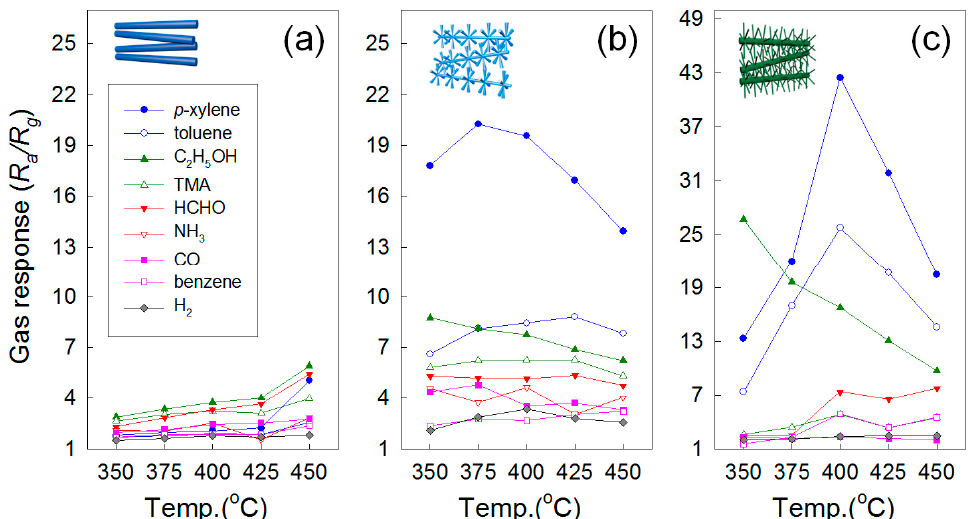
Figure 11. Gas response of ( a ) pristine ZnO; ( b ) Co-doped branched ZnO NWs; and ( c ) Ni-doped branched ZnO NWs to 5 ppm p -xylene, toluene, C 2 H 5 OH, TMA, HCHO, NH 3 , CO, benzene, and H 2 at 350–450 °C. Reproduced from [131,137] with permission; ( a , b ) [137] Copyright (2014) American Chemical Society; ( c ) [131] Copyright (2015) Elsevier.